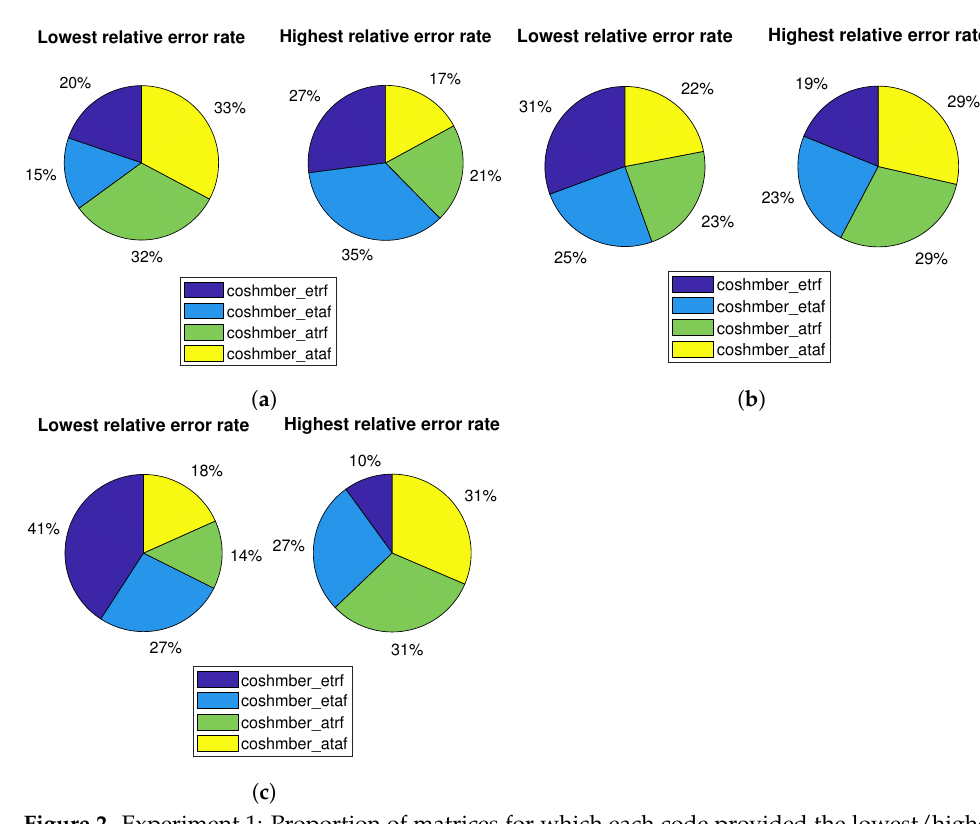
Figure 2. Experiment 1: Proportion of matrices for which each code provided the lowest/highest error for matrix sets 1 ( a ), 2 ( b ) and 3 ( c ).